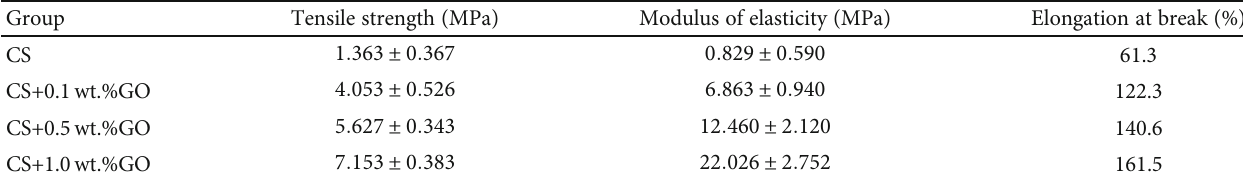
Table 2: Physical properties of the CS/GO hydrogel sca ff olds with di ff erent contents of GO.